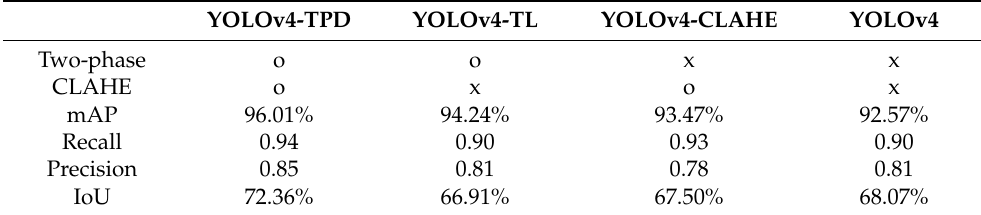
Table 3. The detection results of fashion apparel.